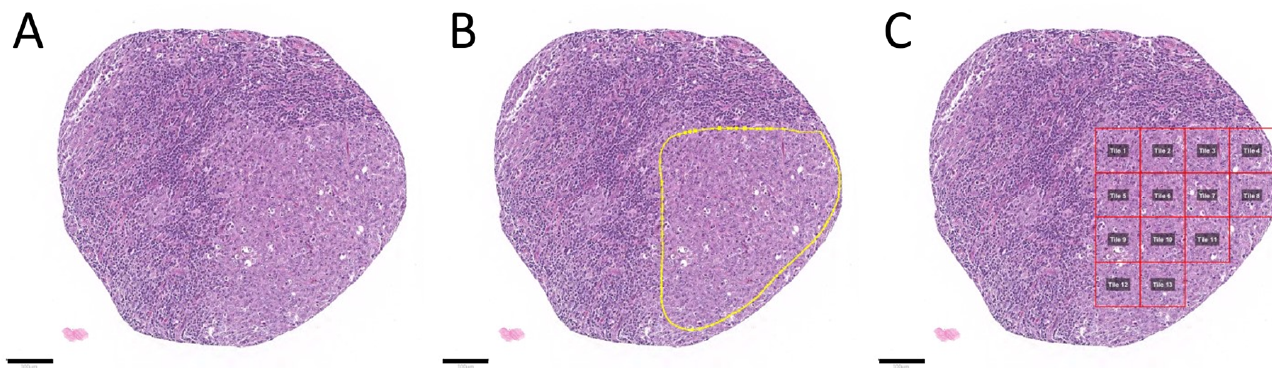
Figure 1. Tumor annotation and generation of image patches. Representative tissue microarray core of a diffuse large B-cell lymphoma without ( A ) and with annotation ( B )—yellow outline, as well as after image patche creation ( C )—red squares. The image patches were subsequently saved as .png files. Tile numbers (Tile 1, Tile 2, etc.) are shown in a gray box within each red square in this example. Scale bars (black line): 100 µm.